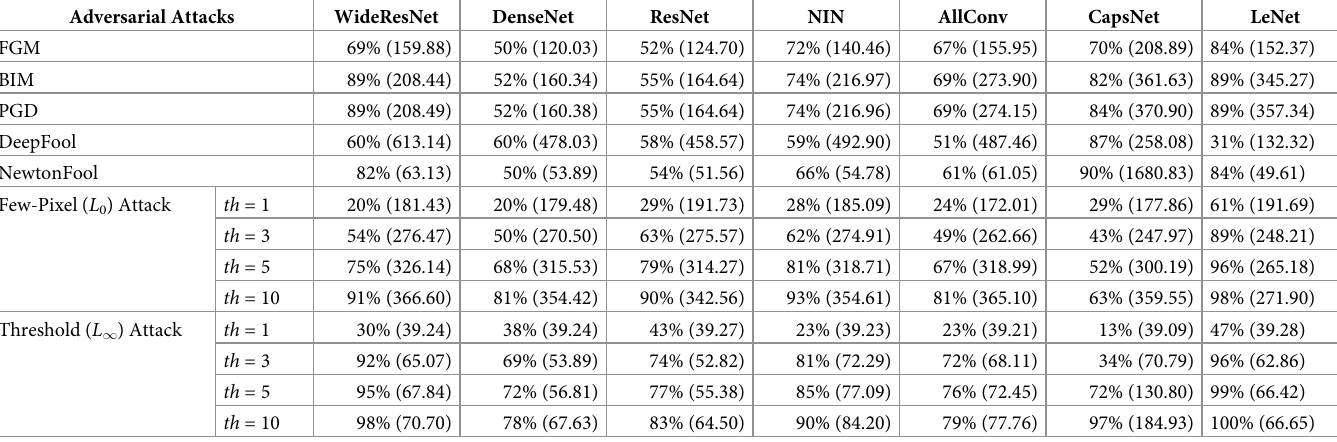
Table 7. Adversarial accuracy of the proposed L 0 and L 1 black-box attacks used in the robustness assessment compared with other methods from the literature. Adversarial Attacks